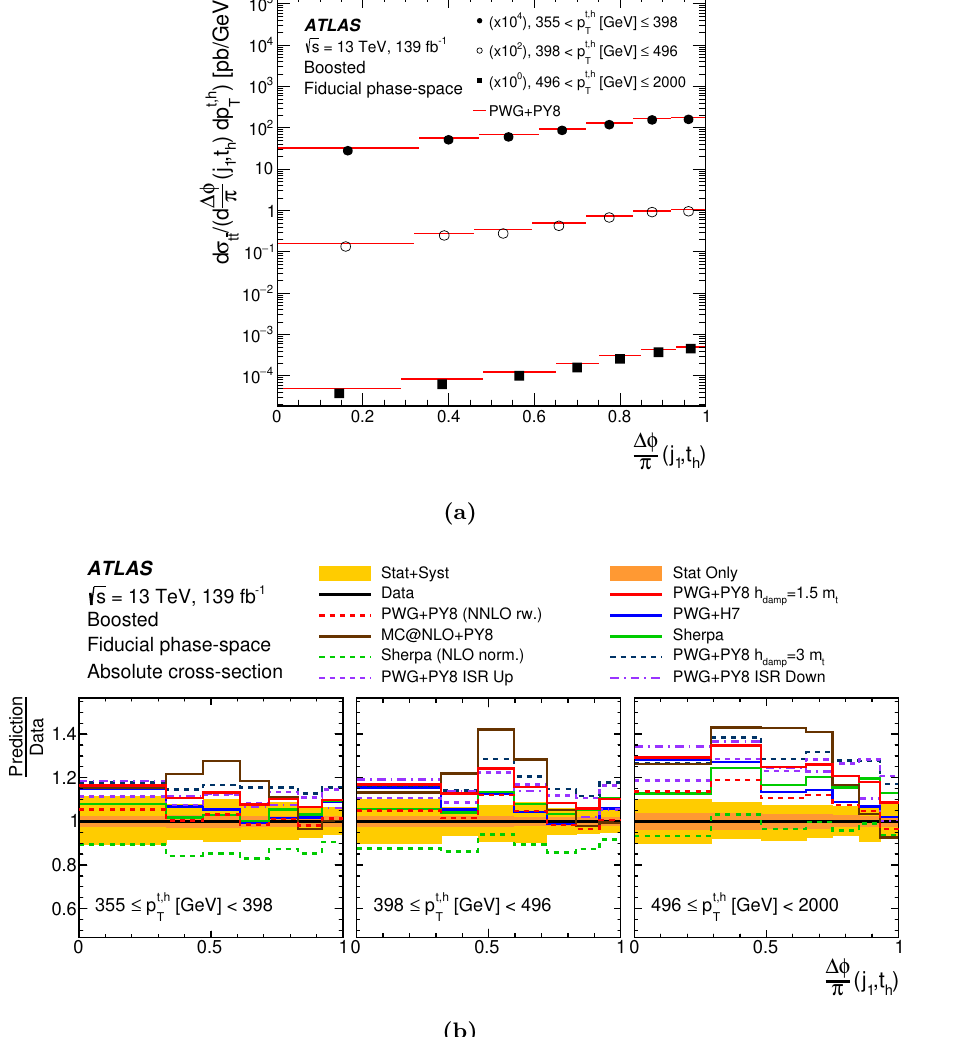
Figure 16. (a) Differential cross-section measurements as a function of the ∆ φ angle between the leading additional jet and the hadronically decaying top quark in bins of p t,h are compared with the T prediction from the Powheg+Pythia MC generator. The measurement and the predictions are normalised by the factors shown in parentheses to aid visibility. (b) Ratio of the measured absolute cross-section to different NLO, and NLO reweighted to NNLO, predictions of t ¯ t signal for the same differential variables. PWG+PY8 corresponds to the Powheg+Pythia sample, PWG+H7 to the Powheg+Herwig sample and MCatNLO+PY8 to the MadGraph5_aMC@NLO+Pythia sample. The yellow band represents the total uncertainty of the measured differential cross-section while the orange band shows the statistical